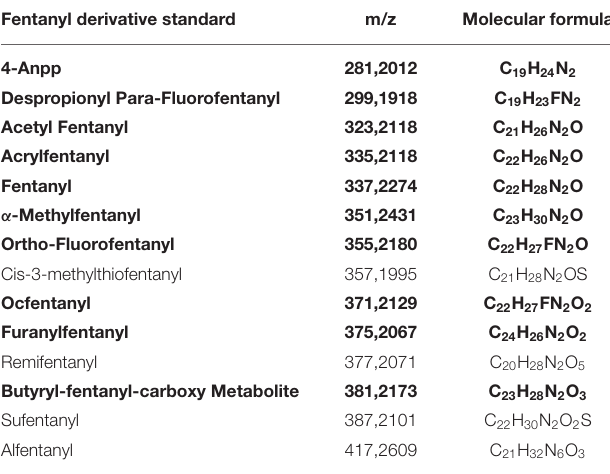
TABLE 2 | Fentanyl derivatives included in the standard mixtures. Fentanyl derivative standard Molecular